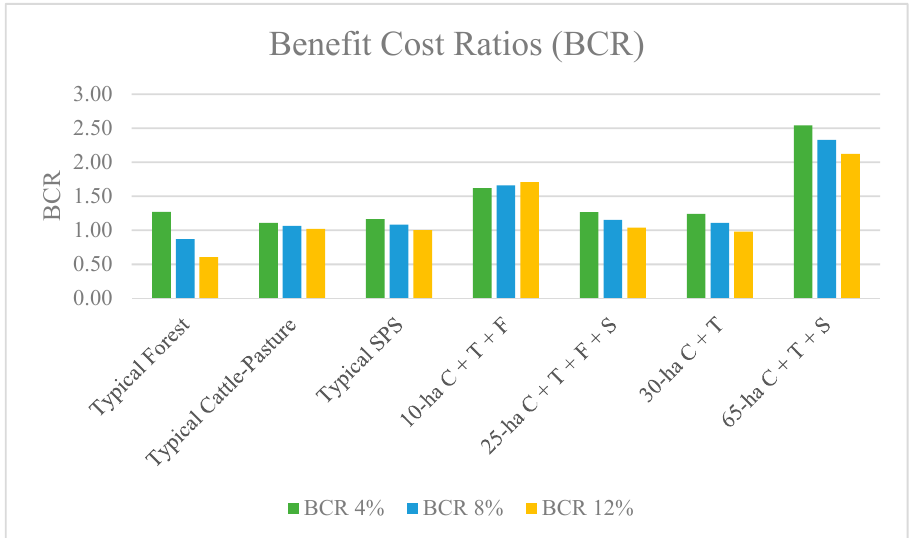
Figure 3. Benefit-cost ratios (BCR) for the evaluated scenarios.